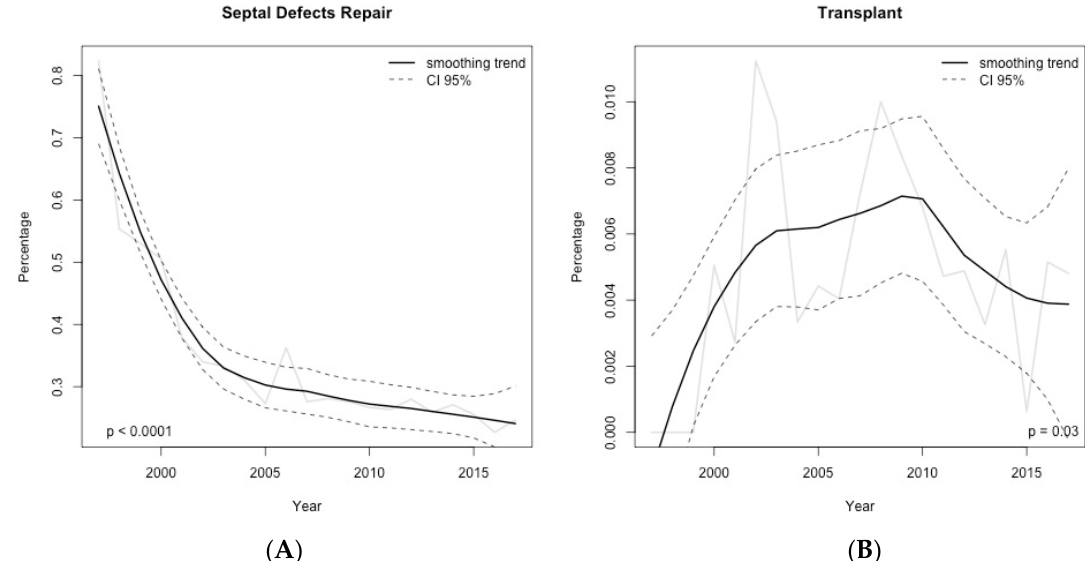
Figure 4. Time–series of the relative frequencies computed year-by-year for the main procedural surgical groups in adult patients with congenital heart disease. ( A ) septal defects repair; ( B ) transplants. Data shown as rough number of the relative frequencies (solid black line) and smoothed trend (solid gray line) with 95% confidence interval (dashed black line).